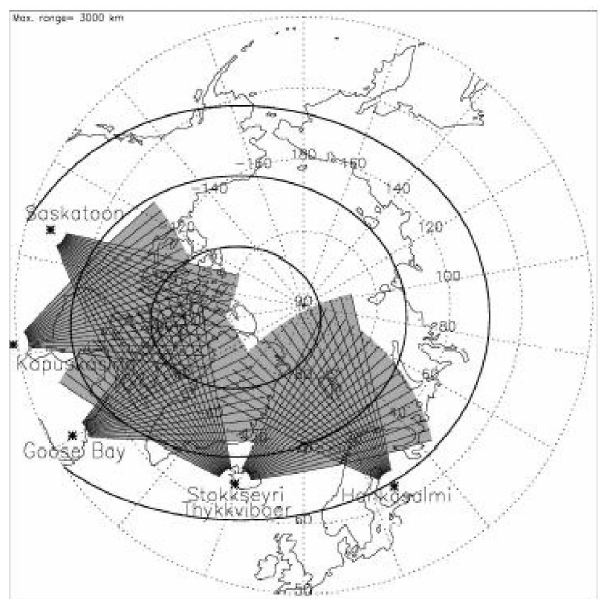
Fig. 1. Location and fields of view of the SuperDARN radars used in this study. The thick line contours mark 60 ◦ , 70 ◦ and 80 ◦ Invari- ant